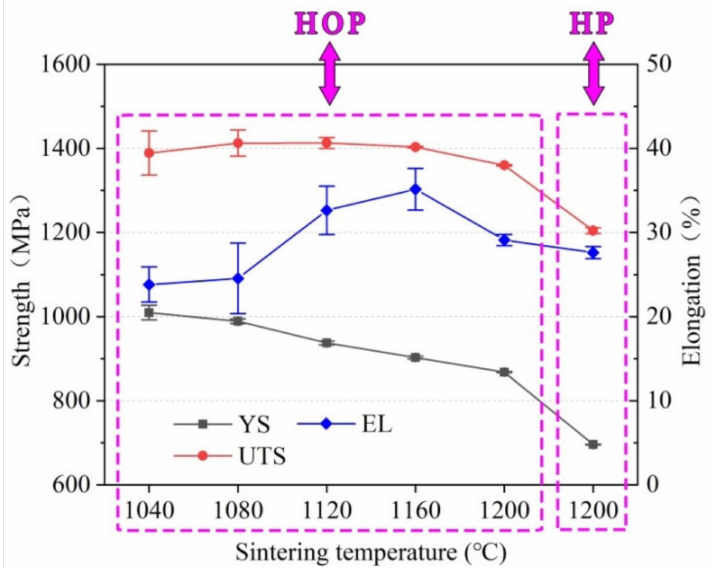
Figure 8. Room temperature tensile properties of the HOPed and HPed